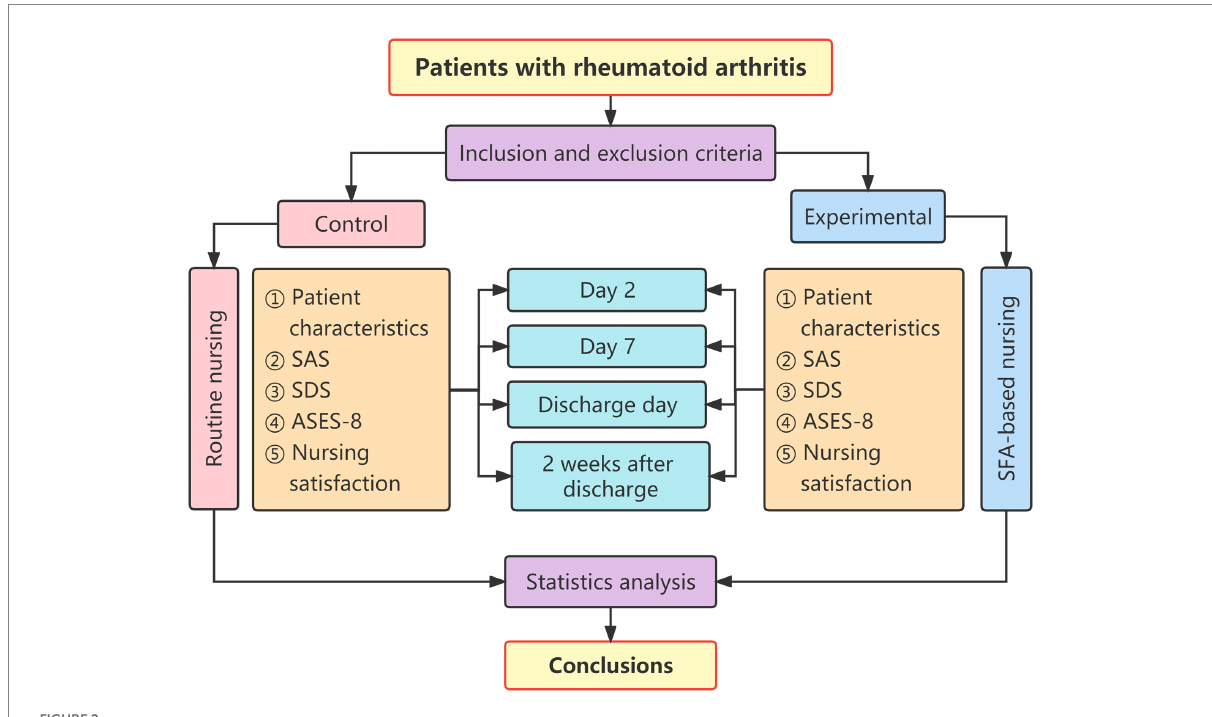
FIGURE 2 The timepoints and content of